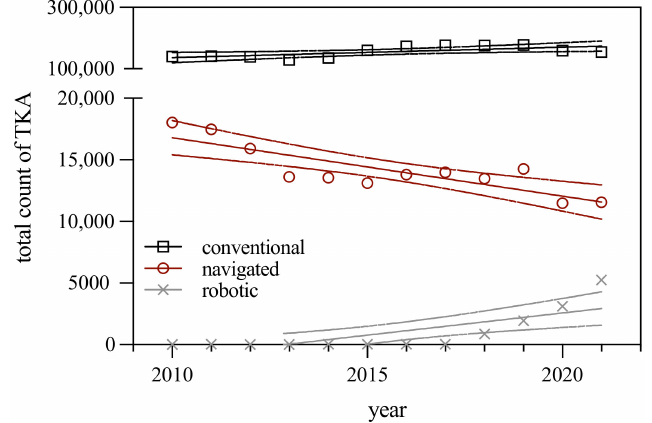
Figure 1. Total number of three different types of TKA (conventional, navigated and robotic) per- formed in Germany between 2010 and 2021. Illustrated are the regression lines as well as the 95% confidence intervals. Complementary data for the regression lines are given in Table 1.